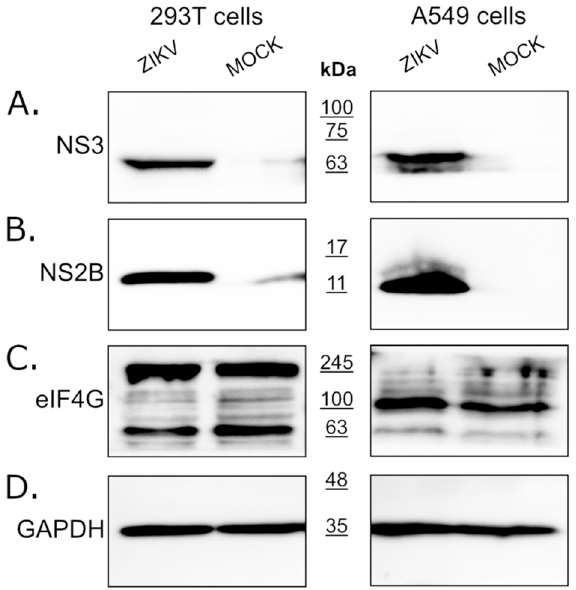
Figure 2. Expression of the eIF4G1 protein in ZIKV-infected and mock-infected cells. The 293T (left panel) and A549 (right panel) cells were infected with ZIKV or inoculated with a mock and analyzed by Western blotting. Virus infection was confirmed by the presence of NS3 ( A ) and NS2B ( B ) proteins. The eIF4G1 protein was detected using an anti-eIF4G1 antibody ( C ). The GAPDH protein was used as a reference to ensure that identical amounts of proteins were present in each sample ( D ).